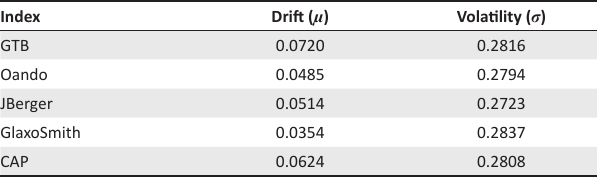
FIGURE 5: Chemical and Allied Product (CAP) (a) stock pricing over time, (b) returns over time. TABLE 2: Drift and volatility values of stock